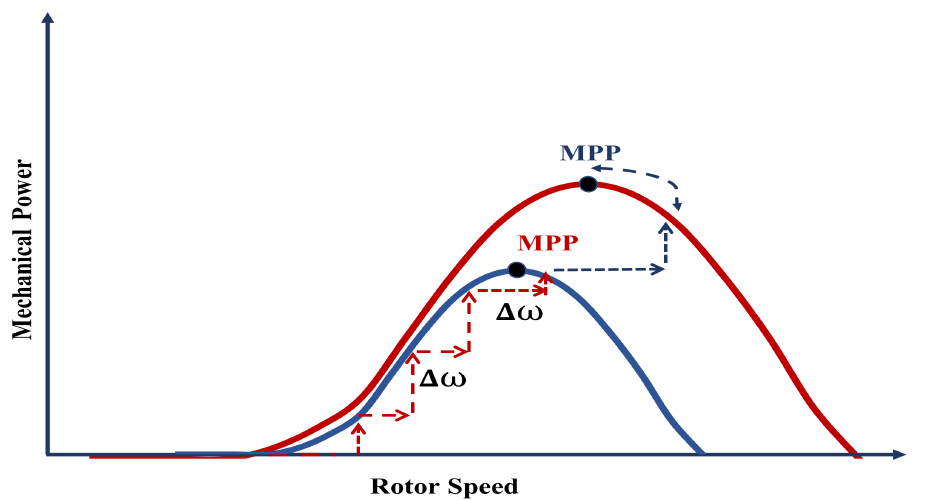
Figure 12. Problem of tracking MPP under varying speeds of the wind. Reused with permission from ref. [3]. Copyright Elsevier